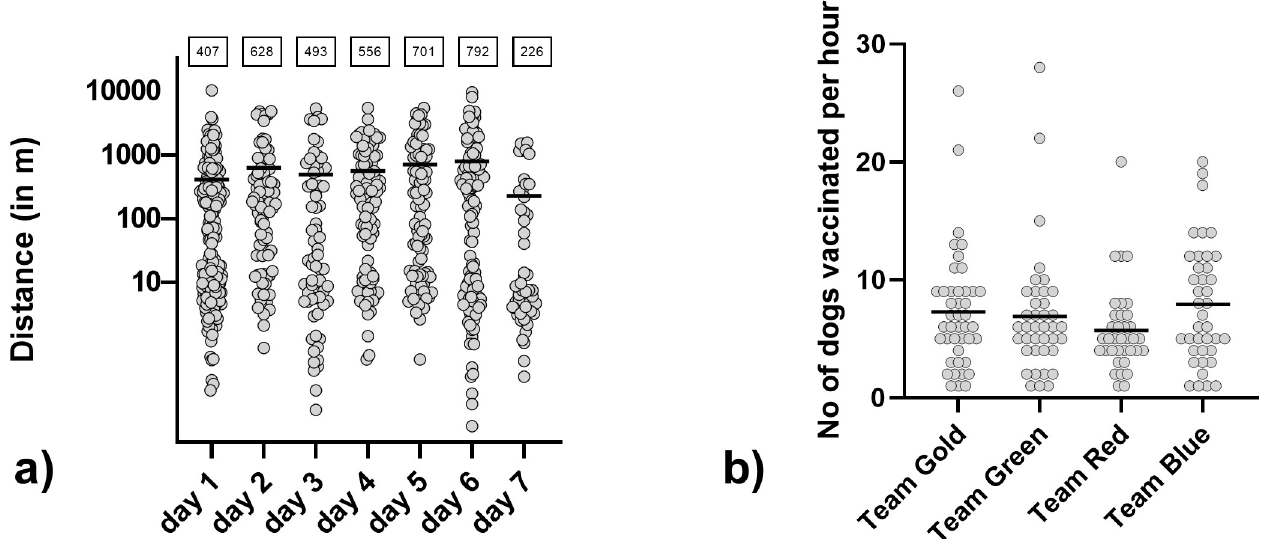
Fig 2. Euclidian distance between consecutively baited dogs per day as calculated by their individual GPS-tracked position (a), with the mean indicated (value shown in boxes). Number of dogs vaccinated per hour and team (b).